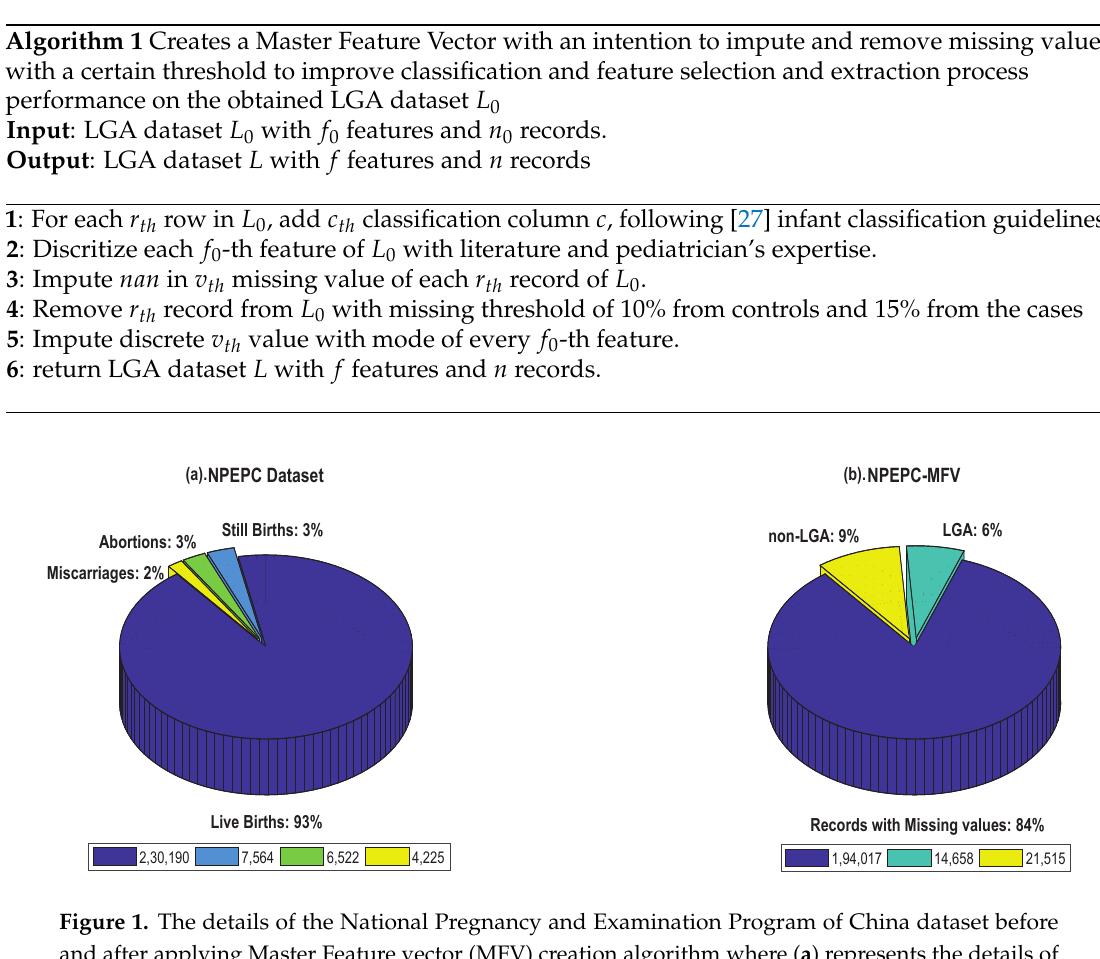
Algorithm 1 Creates a Master Feature Vector with an intention to impute and remove missing values with a certain threshold to improve classification and feature selection and extraction process performance on the obtained LGA dataset L 0